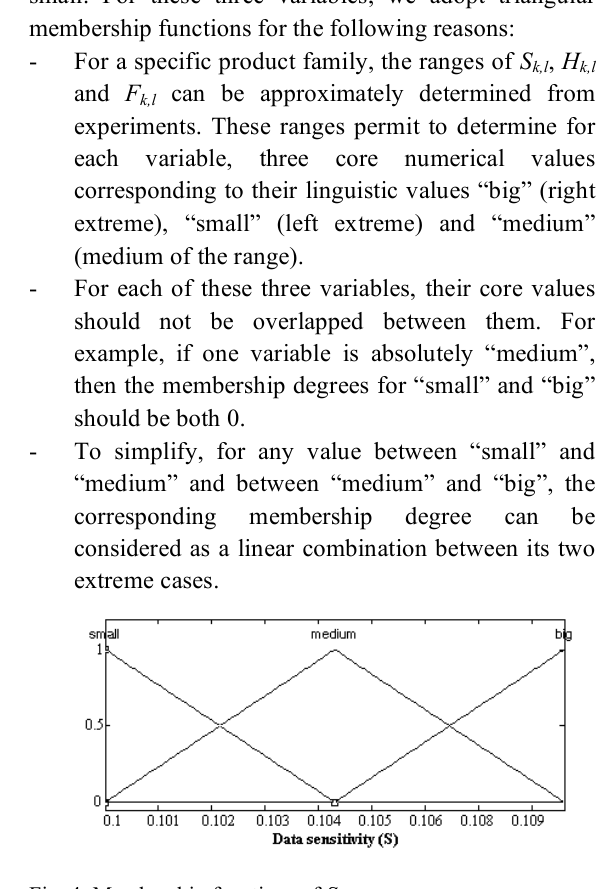
Fig. 4. Membership functions of S